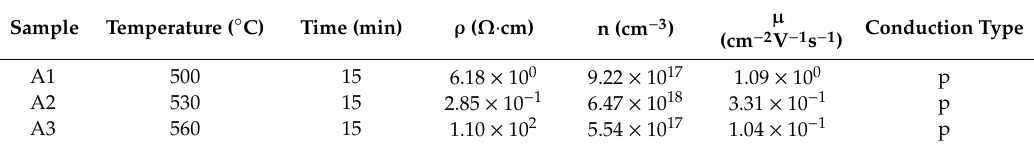
Table 3. Electrical properties of the CMZTSSe films annealed at di ff erent temperatures from 500 to 560 ◦